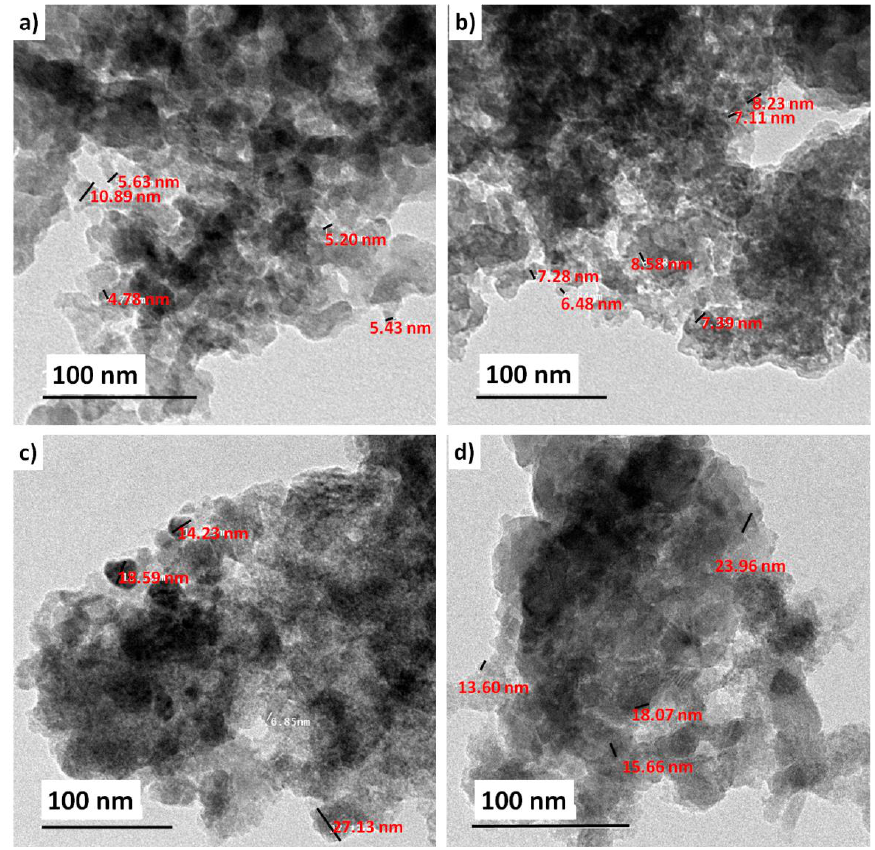
Figure 4. Transmission electron micrographs of TiO 2 -doped glass with reference to the native glass; ( a ) Base, ( b ) BGT5, ( c ) BGT7.5 and ( d ) BGT10.